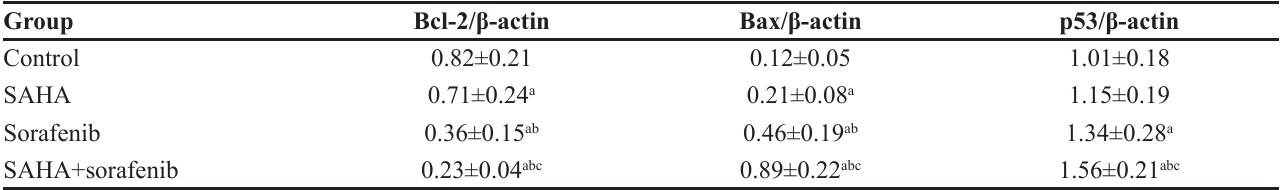
TABLE IV - Expression of Bcl-2, Bax and p53 protein in xenograft tissue (relative to β-actin) Group